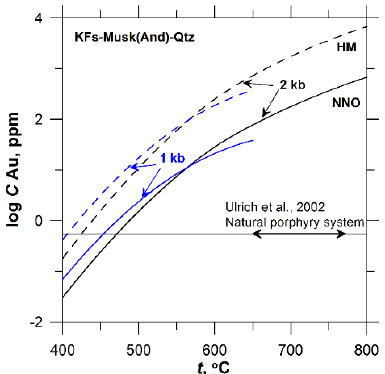
Figure 6. The solubility of Au as a function of temperature at 1 and 2 kbar (blue and black lines, respectively). The pH value is controlled by the K-feldspar – muscovite – quartz buffer at t < 550 °C at 1 kbar and t < 600 °C at 2 kbar and the K -feldspar – andalusite – quartz buffer at higher temperatures. The redox state of the system corresponds to the Fe 2 O 3 /Fe 3 O 4 (HM) and Ni/NiO (NNO) buffers. The horizontal line shows the concentration of Au (0.55 ppm) determined in the highest-temperature fluid inclusions from the Bajo de la Alumbrera porphyry Cu – Au deposit (Argentina, Ulrich et al. [2]).